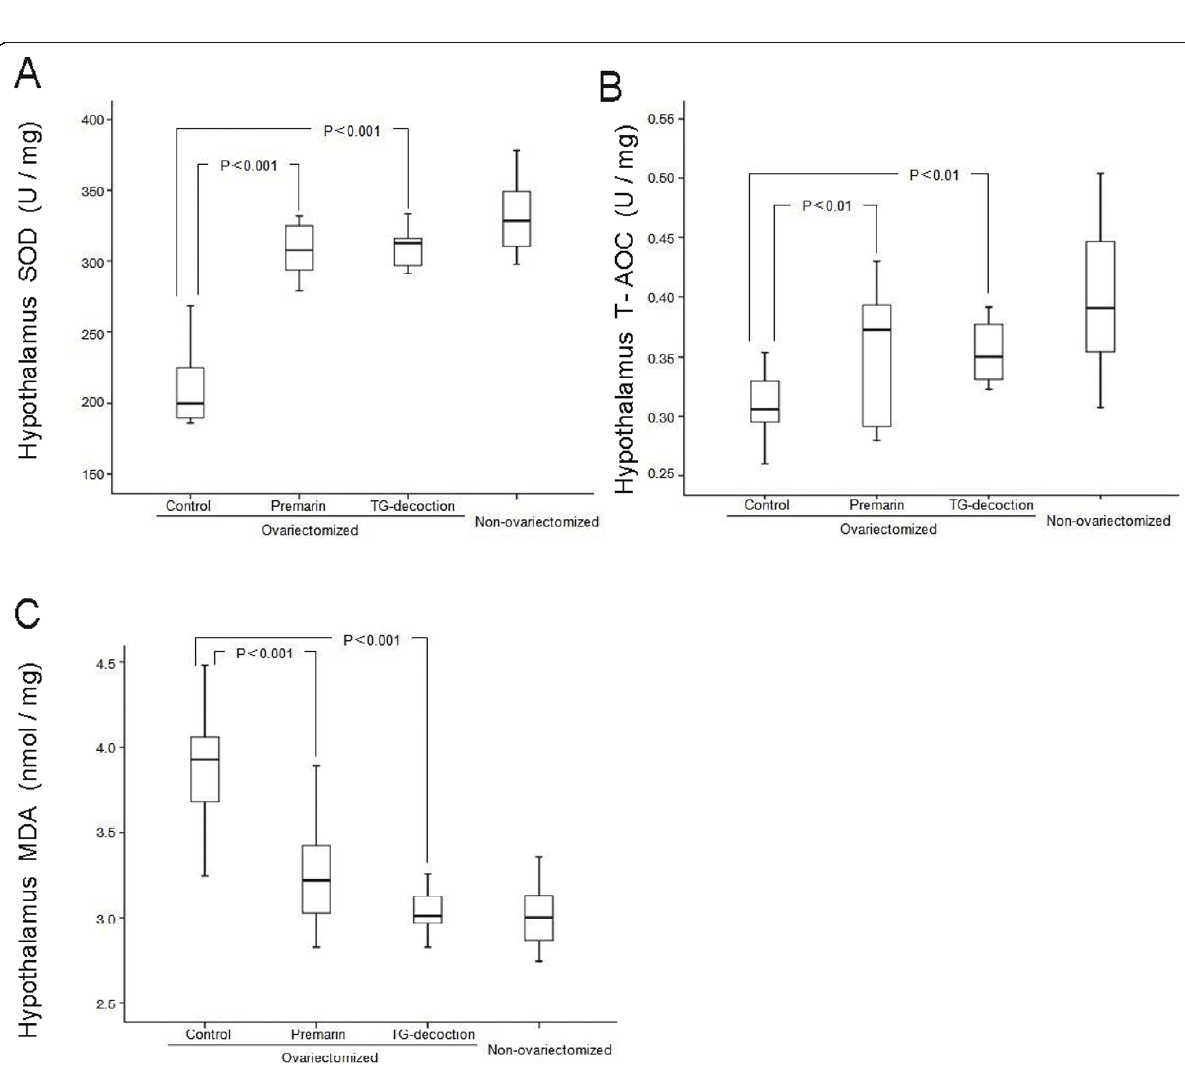
Figure 3 Antioxidant activity and peroxidation damage . Antioxidant activity parameters SOD, T-AOC (A, B) and peroxidation damage parameter MDA (C) in untreated (control), Premarin-treated, TGT-treated ovariectomized rats, and in non-ovariectomized rats. Significance levels of differences to the control group are indicated in the